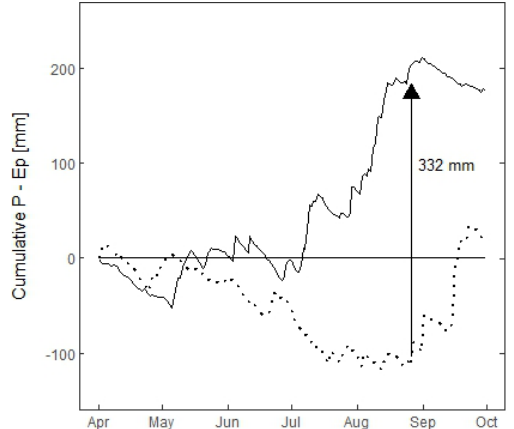
Figure 3. Cumulative precipitation surplus ( P − E p ) from April to October for 2014 (solid line) and 2015 (dashed line). The difference in precipitation surplus between the 2 years was largest at the end of August, as indicated by the